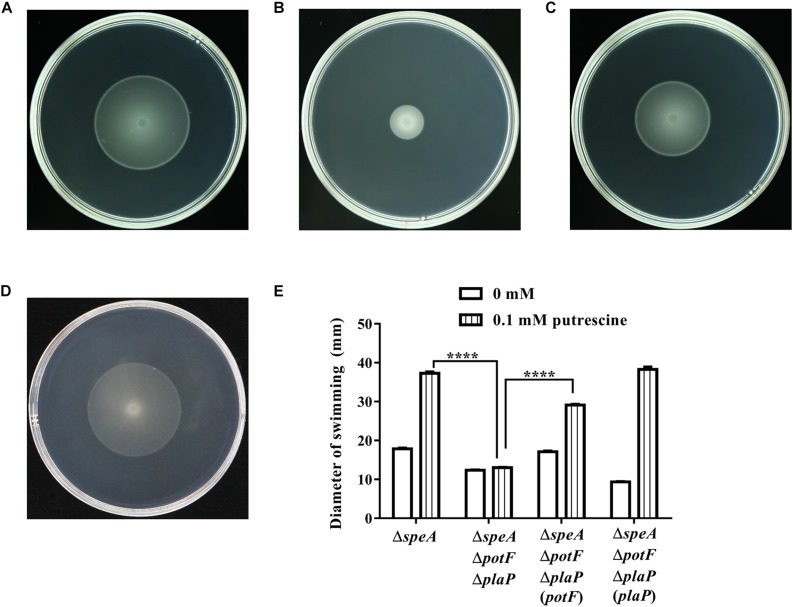
Influence of transporters on putrescine uptaking. The plate bioassay was performed using swimming motility supplemented with 0.1 mM of putrescine for 24 h at 28°C. (A) The speA-disrupted mutant; (B) The potF-plaP double disrupted mutant in the speA-disrupted genetic background (ΔspeAΔpotFΔplaP); (C,D) the complemented strains ΔspeAΔpotFΔplaP(potF) (C) and ΔspeAΔpotFΔplaP(plaP) (D); (E) Quantitative measurement of swimming motility of ΔspeA and its derivatives with or without putrescine (CK). The data shown are the means ± SE (n = 3). ****P < 0.0001.